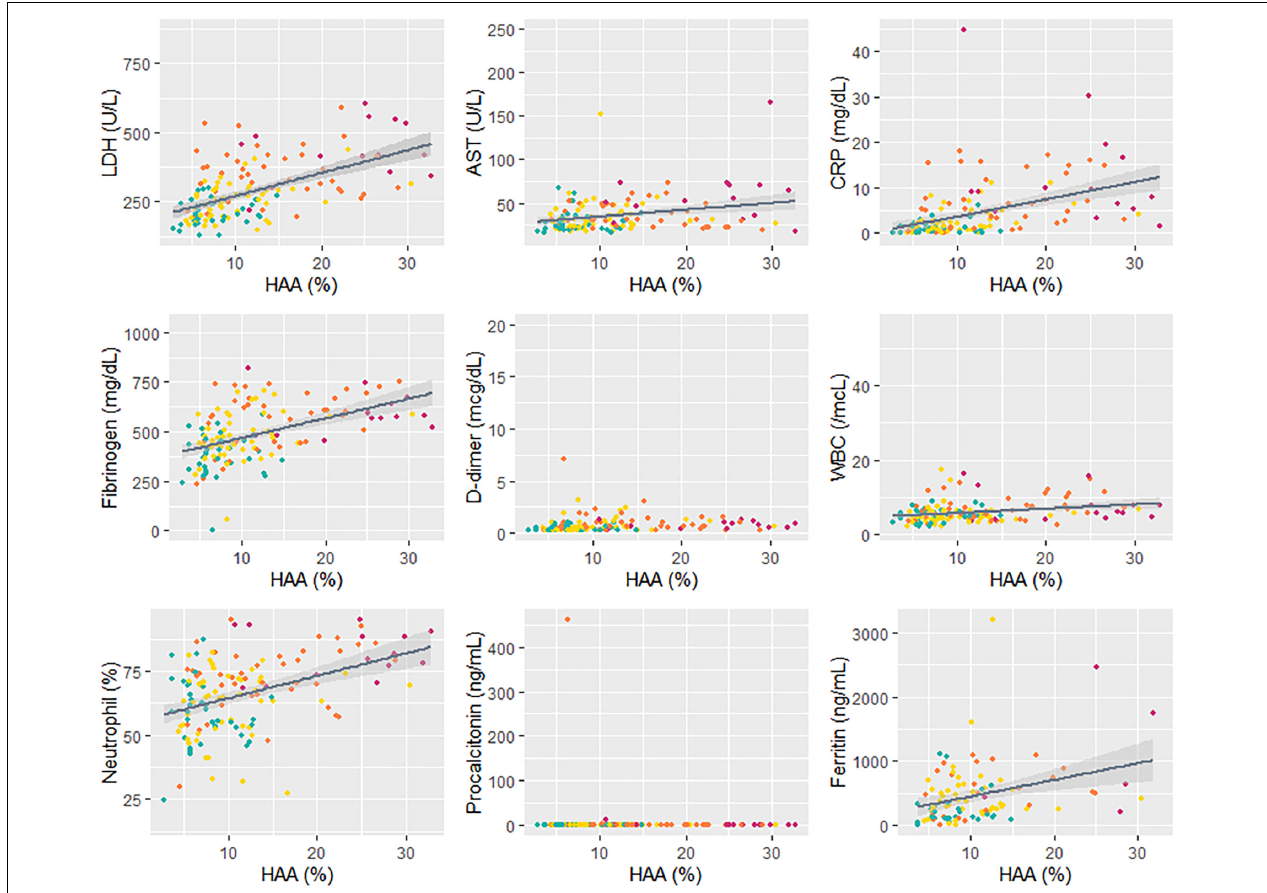
FIGURE 3 | Correlation between HAA and blood biomarkers. A linear regression analysis was performed for total HAA and blood biomarkers. Different colors indicate each respiratory outcome group (green, no pneumonia; yellow, pneumonia without hypoxia; orange, hypoxia without respiratory failure; and red, respiratory failure). The regression coefficients and p-values are as follows: LDH, R = 8.84, p < 0.001; AST, R = 0.76, p = 0.002; CRP, R = 0.37, p < 0.001; fibrinogen, R = 9.49, p < 0.001; D-dimer, R = 0.02, p = 0.21; WBC, R = 151.1, p < 0.001; neutrophil (%), R = 0.88, p < 0.001; procalcitonin, R = 0.004, p = 0.75; ferritin, R = 24.06, p = 0.002. Abbreviation: LDH, lactate dehydrogenase; HAA, high attenuation area; AST, aspartate aminotransferase; CRP, C-reactive protein; WBC; white blood